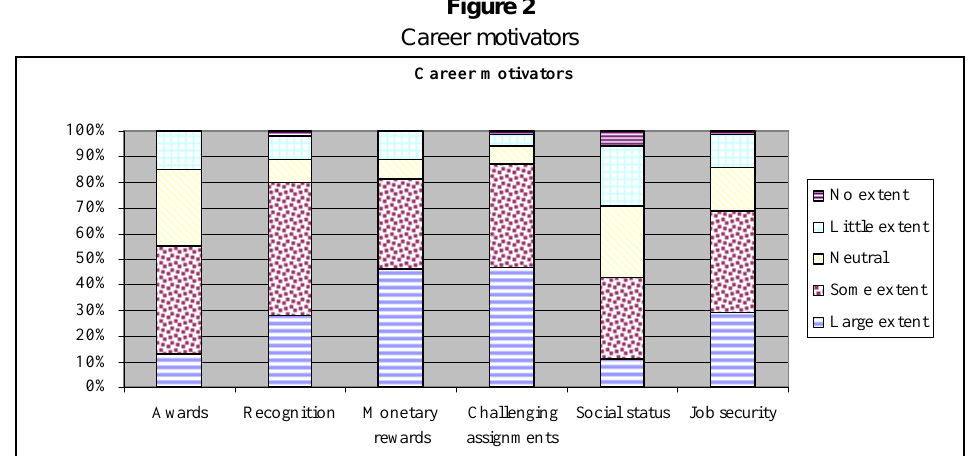
Career motivators Career